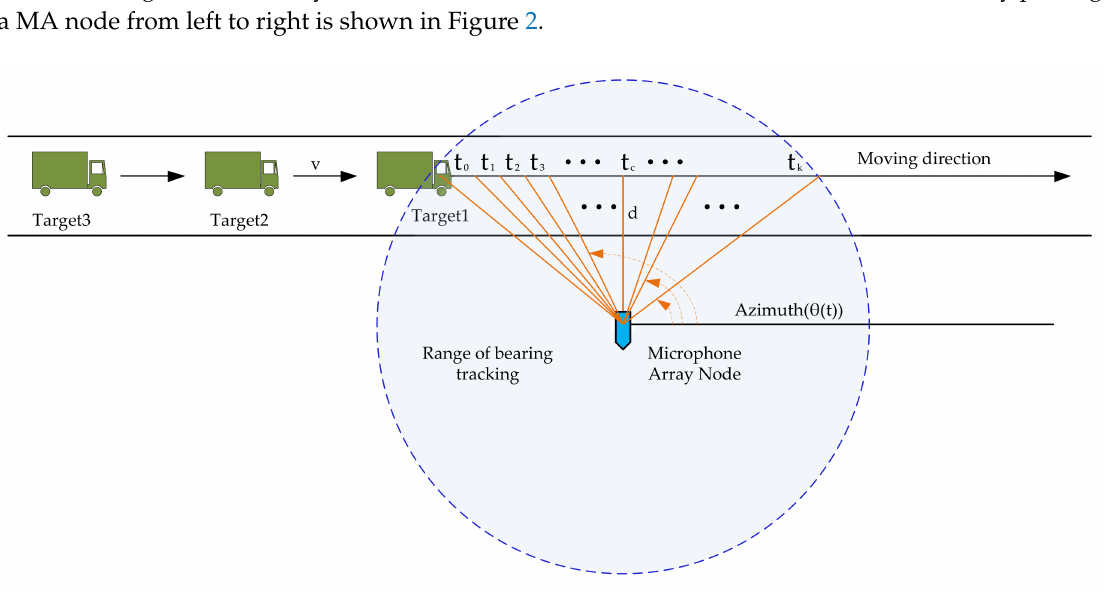
Figure 1. The observation scene of sequential data modeling for bearing tracking.